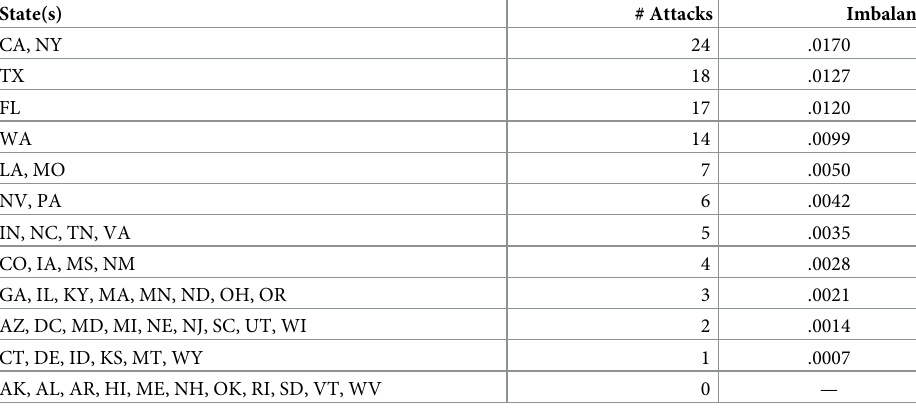
Table 1. Terrorist attack counts between Feb. 18, 2015, and Dec. 31,